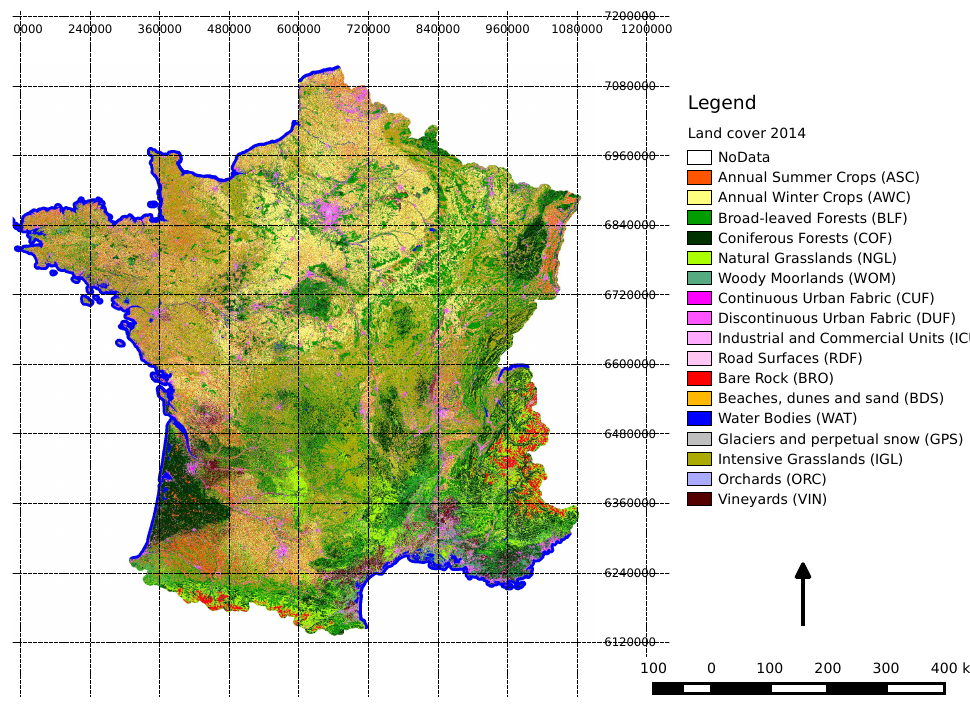
Figure 12. Land cover map for France for the year 2014 using the proposed